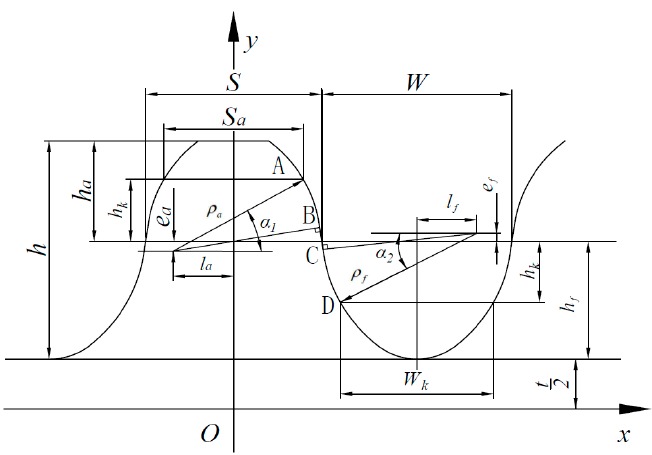
Figure 2. Double-arc tooth profile of flexspline. Convex arc segment AB—see Equation